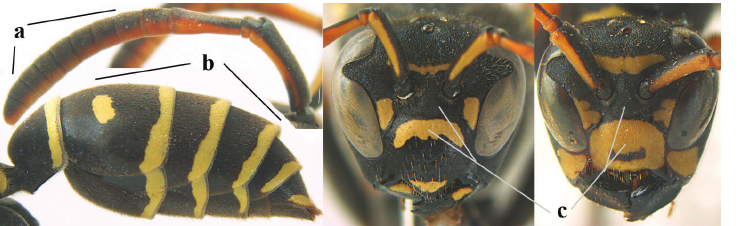
Antenna with 12 segments (a); metasoma with 6 visible tergites and sternites (b); face and/or clypeus with yellow and black pattern (c); females ............. 5